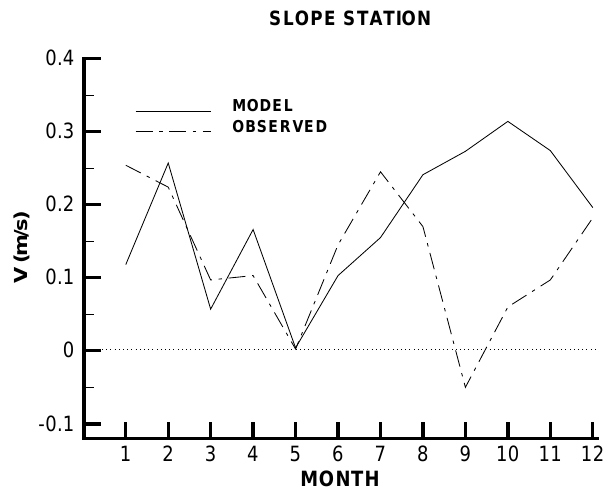
Fig. 16. As in Fig. 8 except for the mid-slope station (current meter depth 40m; water depth